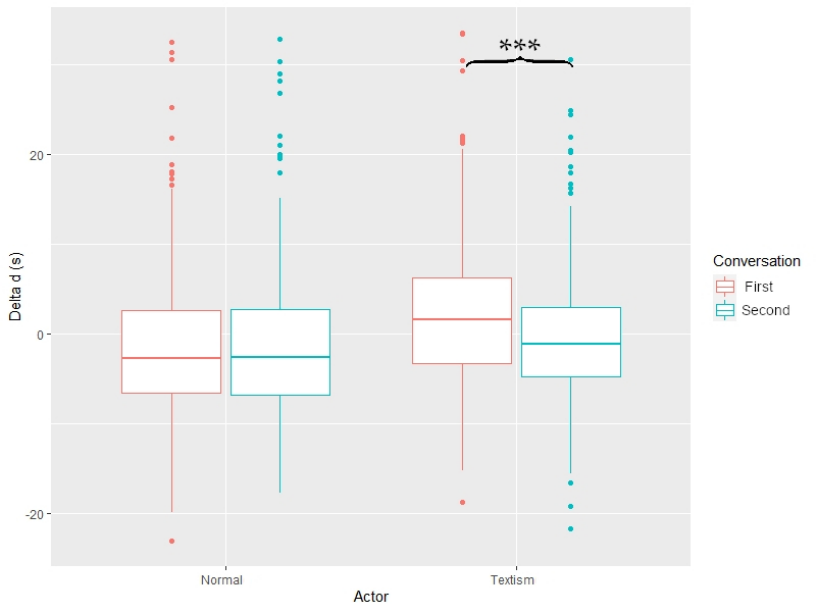
Figure 1. Influence of textisms compared to traditional writing style on ∆ d . Red boxes indicate that the data were recorded in the first conversation, blue boxes that the data were recorded in the second conversation. Data recorded in the conversation with the traditional writing style are shown on the left (Normal), and data recorded in the conversation with textisms is shown on the right (Textism). *** p <